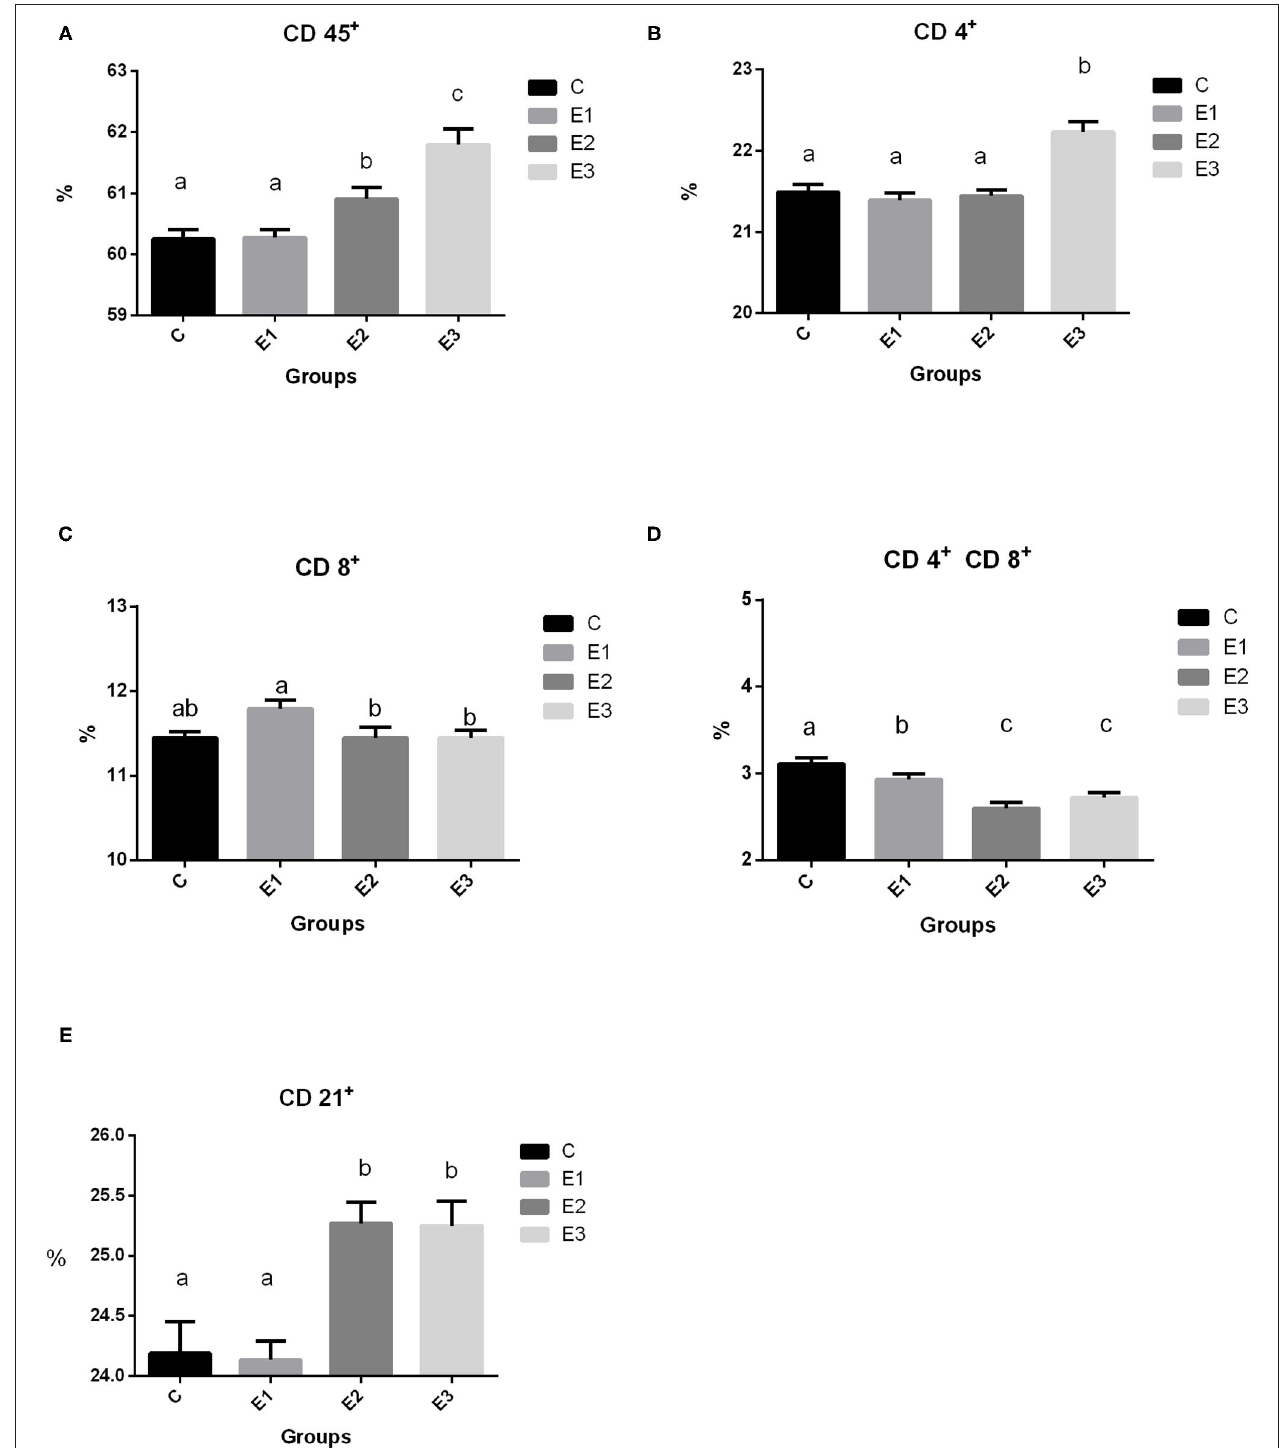
FIGURE 2 | Proportion of lymphoid cell subsets ( A CD 45 + , B 4 + , C CD 8 + , D CD 4 + CD8 + , E CD 21 + ) in the peripheral blood of growing pigs fed with different sources and concentration of selenium. C-0.3 mg/kg DM organic Se, E1-0.5 mg/kg DM inorganic Se, E2-0.5 mg/kg DM organic Se; E3-0.5 mg/kg DM organic Se + 0.2% zeolite clinoptilolite. Values are means ± SEM. Bars with different superscript letters (a, b, c) were different, P <